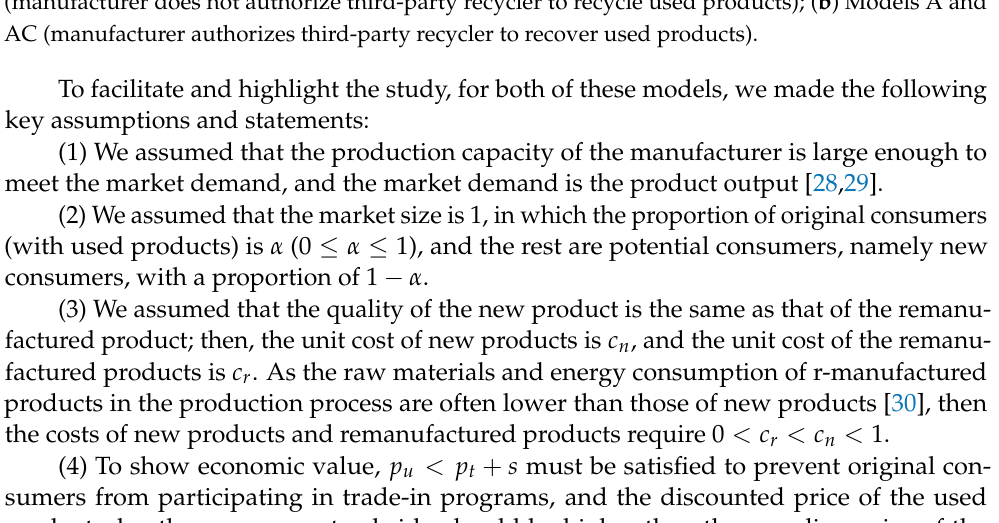
Figure 1. Supply chain model composed of third-party recycler and manufacturer. ( a ) Model